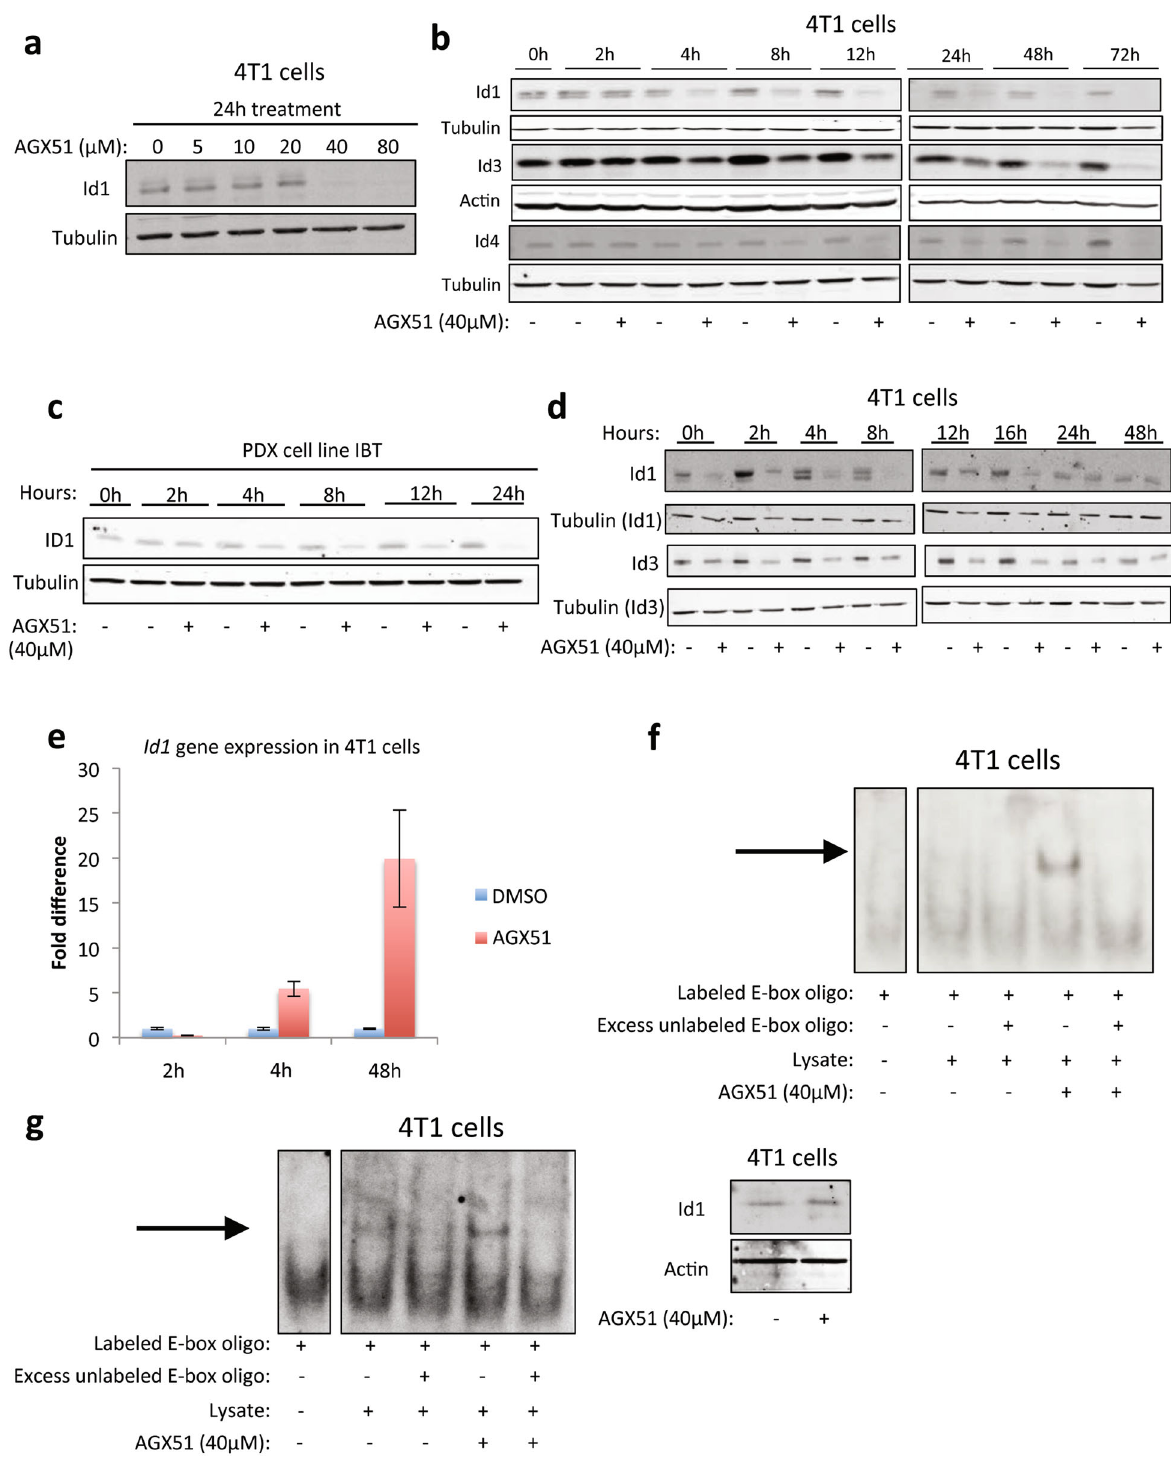
Fig. 1 Effects of AGX51 on ID proteins. a Western blot for ID1 on whole-cell lysates from 4T1 cells treated with 0 – 80 µM AGX51 for 24 h. b Western blot for ID1, ID3, and ID4 on whole-cell lysates from 4T1 cells treated with 40 µM AGX51 for 0 – 72 h. Quanti fi cation of western blot bands is shown in Supplementary Fig. 1a. c Western blot for ID1 on whole-cell lysates from the PDX cell line IBT treated with 40 µM AGX51 for 0 – 24 h. d Western blot for ID1 and ID3 on whole-cell lysates from 4T1 cells treated with 40 µM AGX51 for 24 h, after which compound was washed off and cells were collected for 0 – 48 h post compound removal. e qRT-PCR analysis for Id1 in 4T1 cells treated with 40 µM AGX51 for 2, 4, or 48 h. Mean fold difference with error bars showing standard error of the mean (SEM) of technical triplicates. The experiment was performed at least three times. f Electrophoretic mobility shift assay (EMSA) on whole-cell lysates from 4T1 cells treated with 40 µM AGX51 for 24 h. Arrow indicates binding to DNA. g EMSA on whole-cell lysates from 4T1 cells treated with 40 µM AGX51 for 1 h, with corresponding western blot for Id1 shown to the right of the EMSA blot. Arrow indicates binding to DNA. Tubulin/actin are used as protein loading controls. See also Supplementary Fig. 1. Published in partnership with the Breast Cancer Research Foundation npj Breast Cancer (2021)